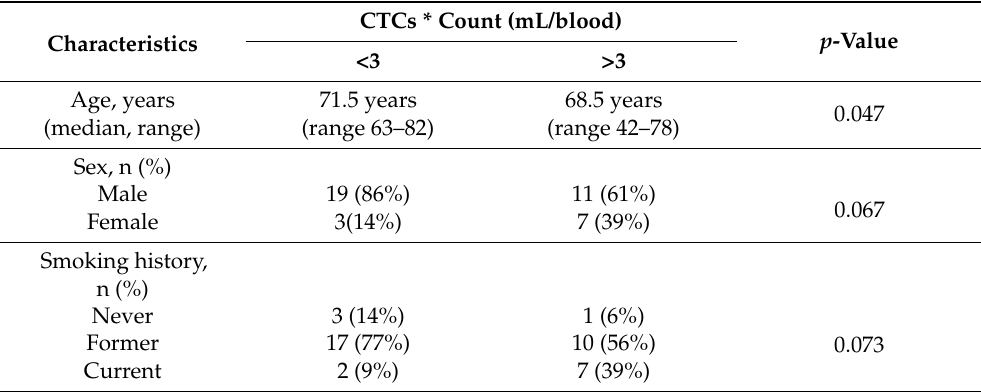
Table 2. Demographics and clinico-pathological patients characteristics according to CTCs count.